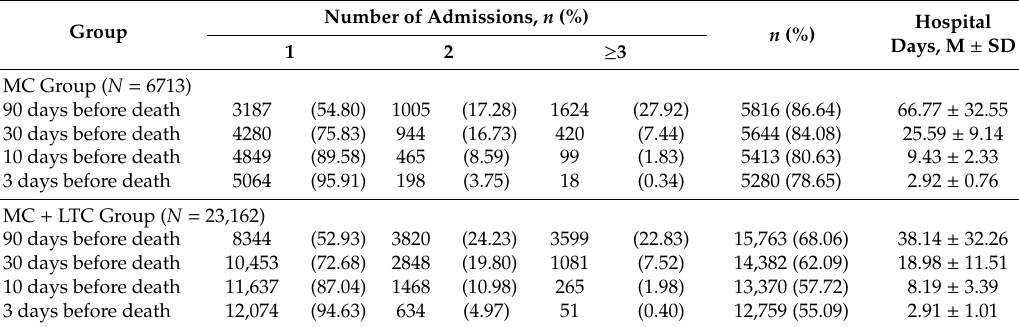
Table 3. Number of admissions and average hospital days at 90, 30, 10, and 3 days before